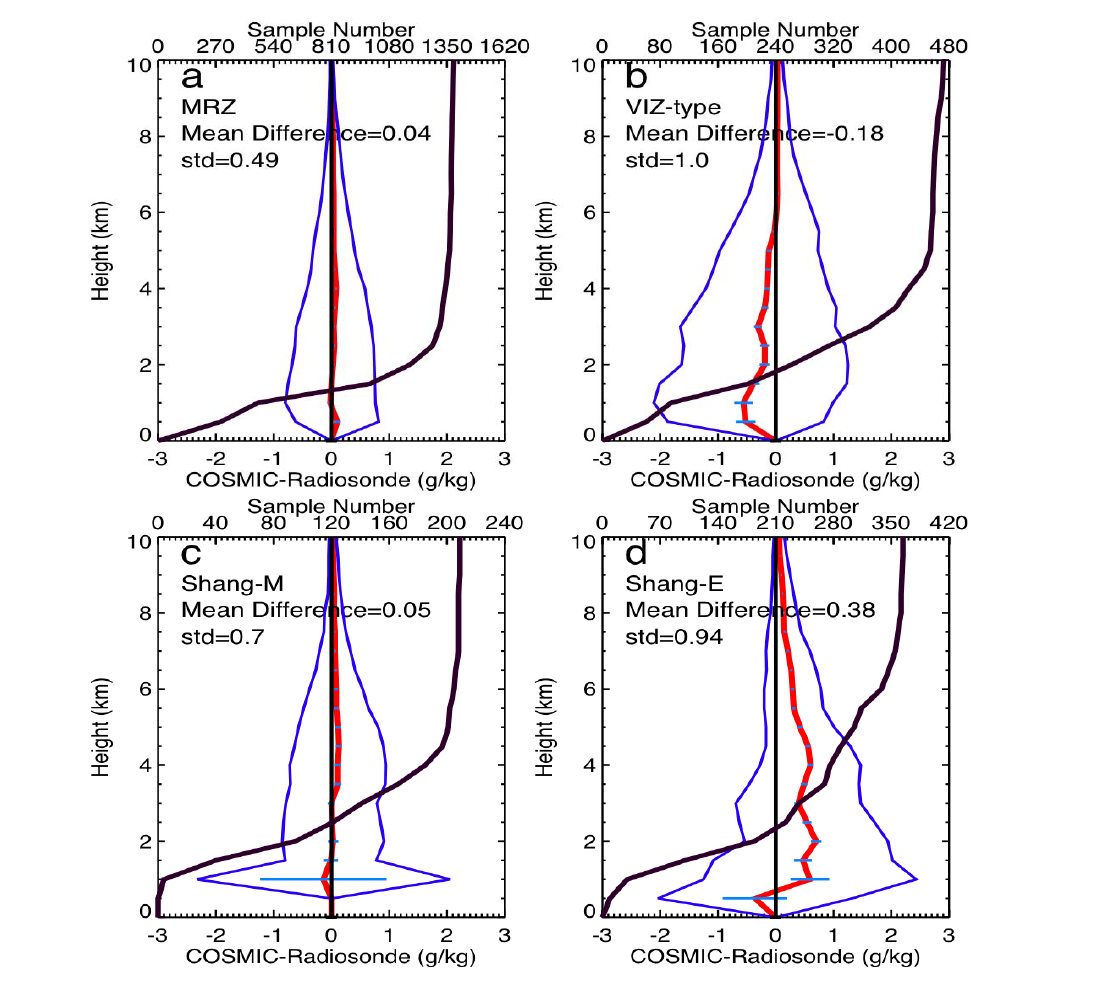
Figure 3. The same as Figure 2 except for COSMIC-Radiosonde